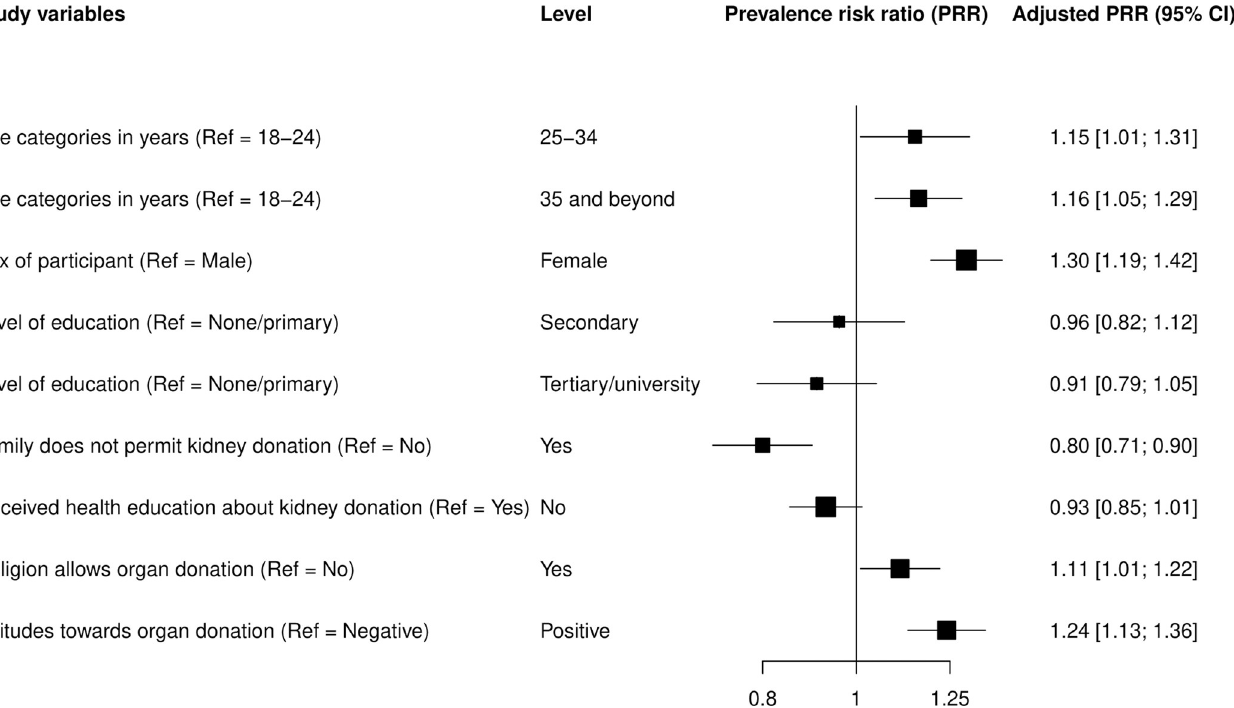
Fig 1. Prevalence risk ratio plot showing results of the adjusted analysis. Willingness to donate a kidney was more likely among participants aged 25–34 years (aPRR, 1.15; 95% CI, 1.01–1.31) and � 35 years (aPRR, 1.16; 95% CI, 1.05–1.29) compared to 18–24 years. Females were 30% more likely to have the willingness to donate a kidney compared to males (aPRR, 1.30; 95% CI, 1.19–1.42). Willingness to donate a kidney was more likely if it was considered by the participant as allowable by their religion than when it was not permissible (aPRR, 1.11; 95% CI, 1.01–1.22). Participants who had a positive attitude toward organ donation were more likely to be willing to donate compared to those who had a negative attitude (aPRR, 1.24; 95% CI, 1.13–1.36). Willingness to donate a kidney was less likely if the family did not permit it (aPRR, 0.80; 95% CI, 0.71–0.90). Secondary (aPRR, 0.96; 95% CI, 0.82–1.12) and tertiary or university levels of education (aPRR, 0.91; 95% CI, 0.79–1.5) and receipt of health education about kidney donation and transplantation (aPRR, 0.93; 95% CI, 0.85–1.01) were not associated with willingness to donate a